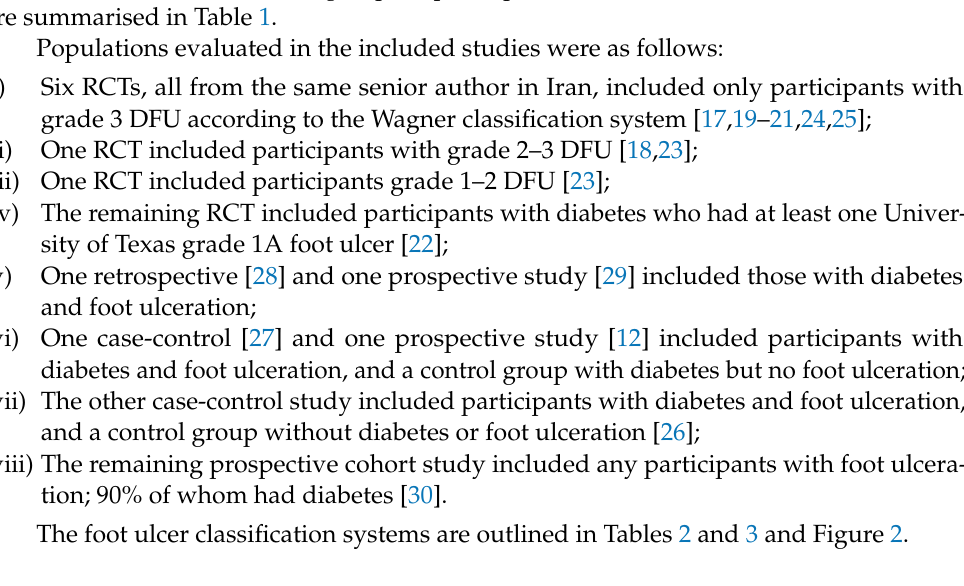
Table 2. Wagner-Meggitt classification.